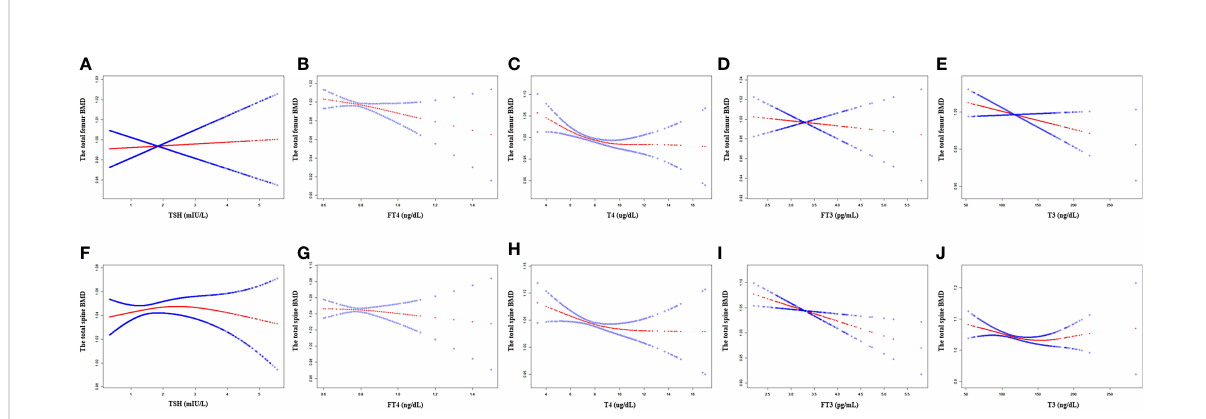
FIGURE 2 Association between the thyroid hormone pro fi le and BMD. (A – E) TSH, FT4, T4, FT3, and T3 with the total femur BMD. (F – J) TSH, FT4, T4, FT3, and T3 with the total spine BMD. Solid rad line represents the smooth curve fi t between variables. Blue bands represent the 95% con fi dence interval from the fi t. Gender, age, education, race, ratio of family income to poverty, hypertension, diabetes, BMI, smoking status, alcohol intake, serum creatine, serum triglyceride, serum total calcium, ALP, and AST were adjusted.